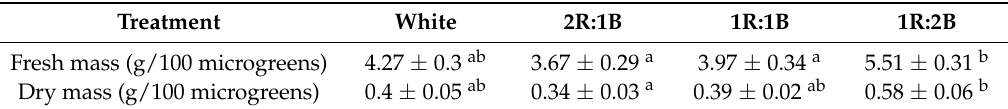
Table 1. Fresh and dry mass of green basil